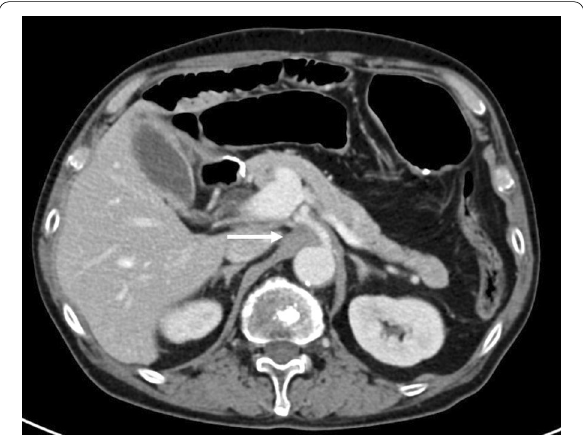
Fig. 5 After 15 months since the nivolumab discontinuation, the size of the metastatic lymph node was 15 mm